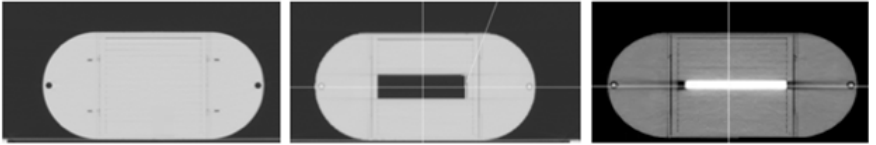
Figure 1. I’mRT Phantom used for verification of the fluence reconstruction accuracy. On the left side, the homogenous slab phantom configuration is shown, in the central part the slab phantom with the air insert is shown, and on the left side the slab phantom with the bone insert is shown.